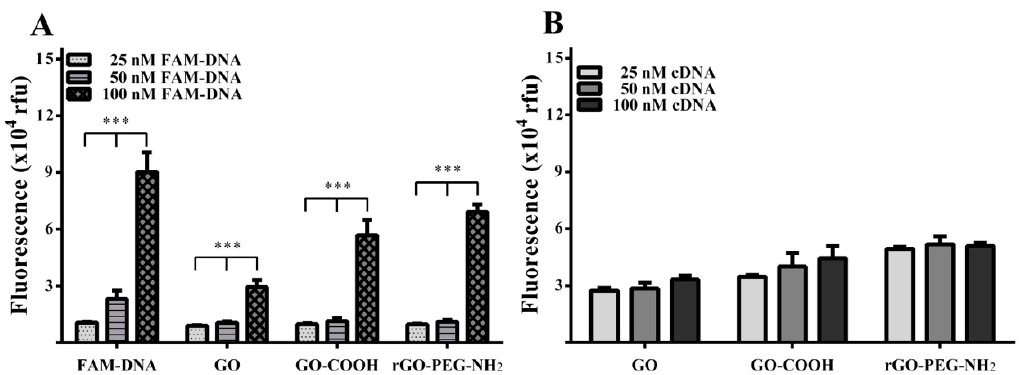
Figure 5. Fluorescence values for different FAM-DNA probe concentrations and three diverse graphenic nanomaterials (10 μ g/mL). ( A ) Fluorescence intensity of different increasing FAM-DNA probe concentrations in the presence of distilled water, GO, GO-COOH, and rGO-PEG-NH 2 . ( B ) Fluorescence of FAM-DNA probe (100 nM) and graphenic material (10 μ g/mL) with addition of increasing concentrations of target cDNA. Error bars represent means ± standard deviation (SD) of n = 3. *** p < 0.001.